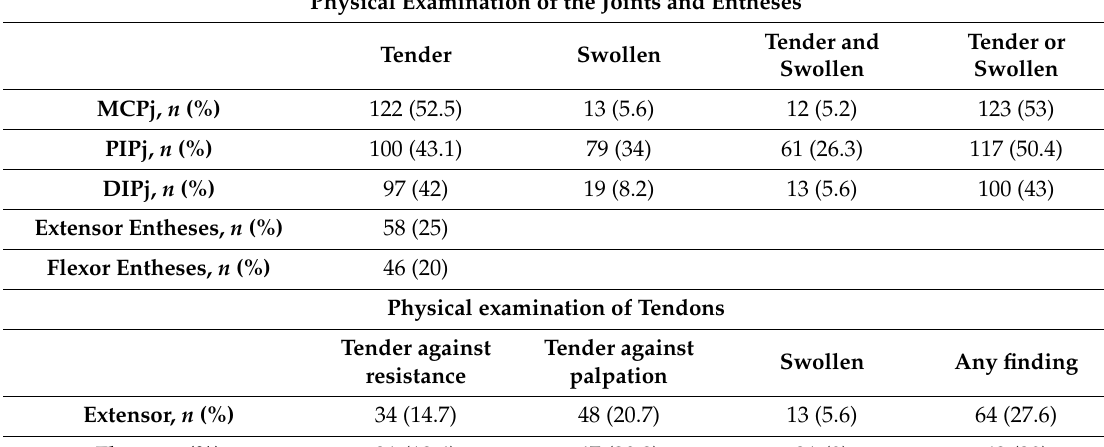
Table 1. Physical examination